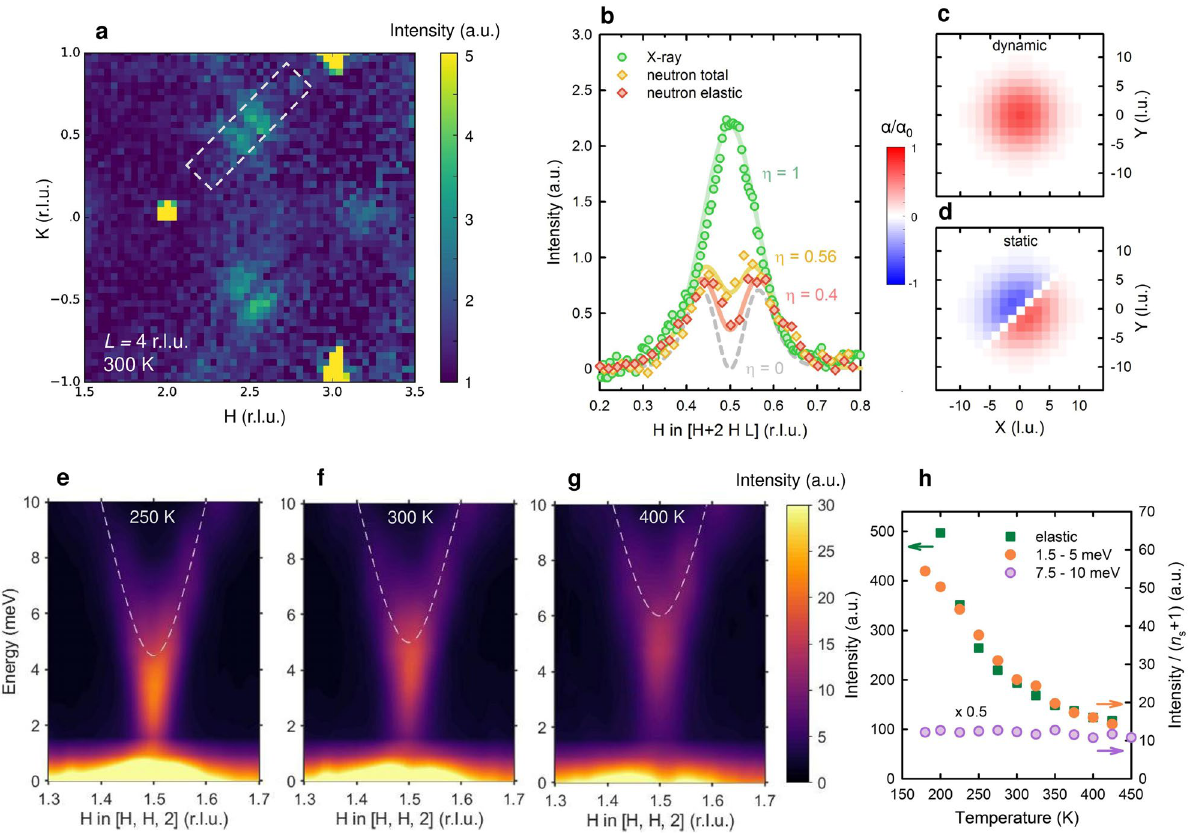
Figure 2. Static and dynamic correlations in overdoped LSCO. ( a ) Quasielastic diffuse neutron scattering in a x = 0.20 crystal at 300 K, far above the HTT-LTO structural transition of about 60 K. The HK 4 plane is shown, integrated within a window of L = 4 ± 0.2 r.l.u. (for an expanded view, see Supplementary Fig. S3). LTO incommensurate diffuse peaks centered at (2.5, ± 0.5, 4) are clearly visible, along with a weak signal around the forbidden Bragg position (3 0 4) that likely corresponds to LTLO tilts. ( b ) Integrated intensity through the superstructure peak along [ H 2 + H 4] (marked with the box in ( a )), for total and quasielastic neutron diffuse scattering (diamonds), as well as X-ray scattering at a similar doping level and temperature (circles). The total and quasielastic neutron data are normalized to the respective intensities of nearby Bragg peaks, whereas the X-ray data are scaled to match the low- H tail of the neutron peaks. Polynomial backgrounds have been subtracted from all three datasets. Lines are calculated diffuse scattering from a single nanoscale orthorhombic domain with local orthorhombic tilt angle α, and a superposition of a dynamic Gaussian contribution (shown in real space in ( c )) and a static contribution with an antiphase boundary (shown in d ). The chosen maximum value α 0 = 5° corresponds to the typical low-temperature long-range tilt 34,44 , the constant η is the relative amplitude of the dynamic contribution, and the same orthorhombic correlation length of about 6 tetragonal unit cells is used for all four curves. The in-plane tetragonal lattice unit is 3.78 Å. ( e – g ) Energy-resolved triple-axis neutron scattering data across the (1.5 1.5 2) LTO diffuse peak, for a x = 0.155 sample ( T LTO = 180 K), measured at 250 K, 300 K and 400 K, respectively. The lowest-lying optical phonon branch (dashed lines, estimated from ref. 42 ; see Methods) exhibits a local minimum and is seen to disperse upward in energy. Additional spectral weight is present below the phonon branch, and the incommensurate quasi-elastic response is clearly seen in the 300 K and 400 K data. ( h ) Temperature-dependent energy- and H- integrated intensity of the inelastic scattering data corrected by the phonon Bose factor n s + 1 (see Methods), showing excess spectral weight below about 5 meV (full circles). This is evidence for a signal from local fluctuations that likely has the same origin as the H -integrated quasielastic incommensurate peak (squares). On the other hand, the Bose factor corrected weight above 5 meV is temperature-independent (purple circles), as expected for a phonon